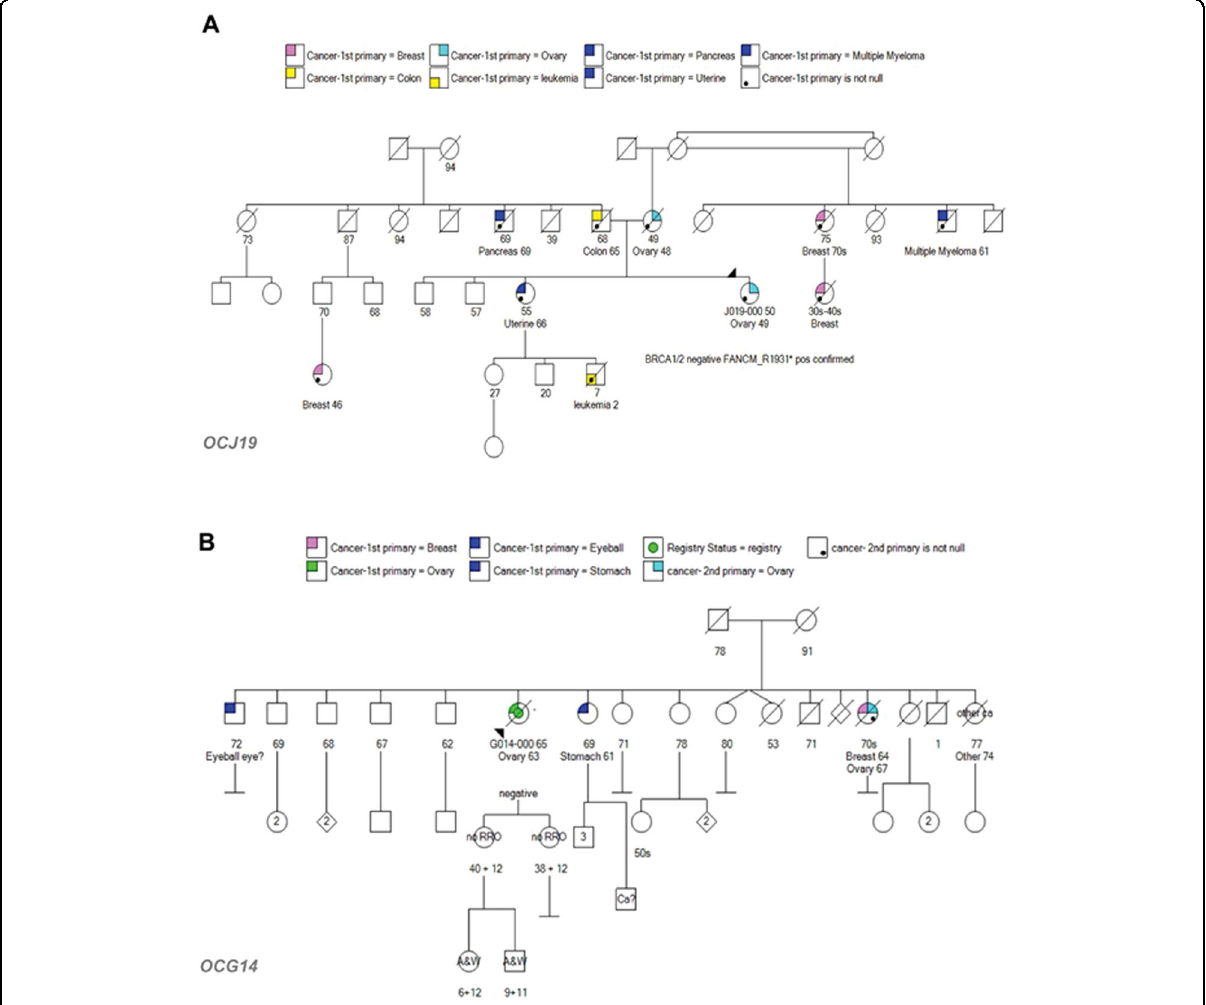
Fig. 1 Patient pedigrees for carriers of TP53I3-S252X. A The TP53I3-S252X and FANCM-R1931X mutation found in the OCJ19 proband (arrow) and has a family history of breast and ovarian cancer. B Patient OCG14 also has a family history of breast and ovarian cancer. No RRO represents no surgical prevention intervention and A&W means the relative is alive and